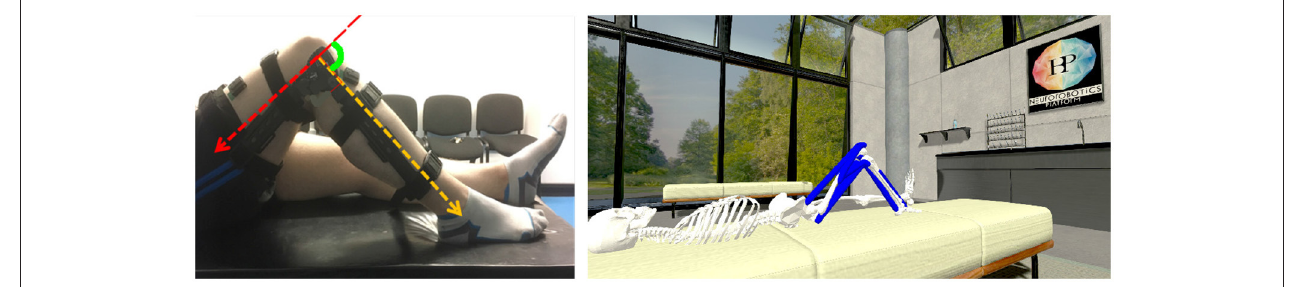
FIGURE 1 | Human knee extension experiment: Participant study with EMG recordings (left) and experiment replication in the Neurorobotics Platform (right) .